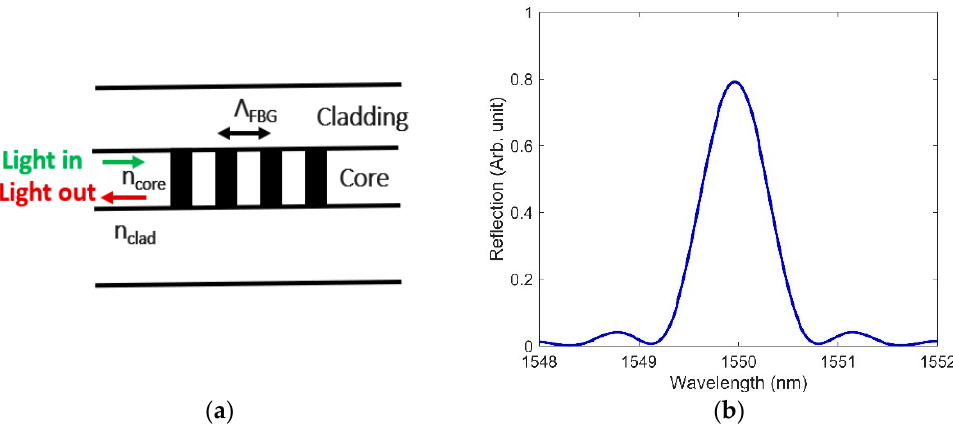
Figure 1. ( a ) FBG schematic, where n core , n clad , and Λ FBG are the RIs of the core, cladding, and grating period, respectively; ( b ) the reflection spectrum of the designed FBG for Λ FBG = 0.5353 µ m and grating strength ( ∆ n ) = 10 − 4